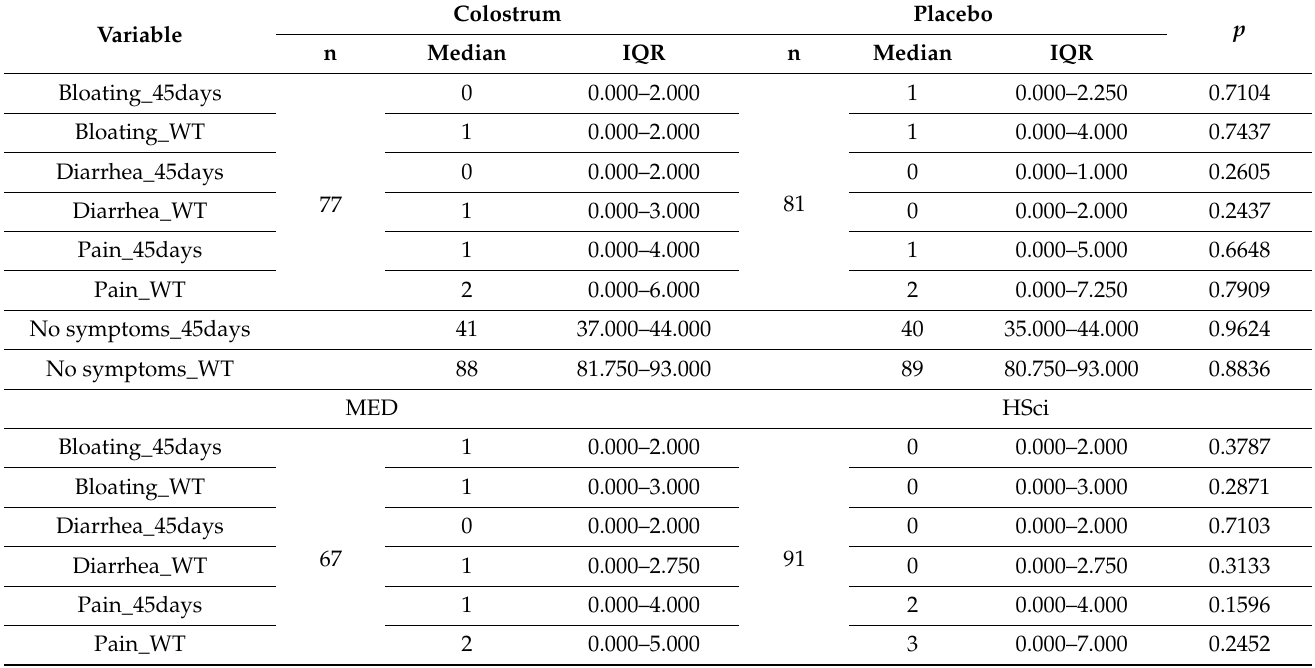
Figure 4. A bar plot on the efficacy of COL in shaping well-being score by the course of studies. Medians and IQRs are shown. Dots and squares depict individual cases. MED—medicine; HSci— health Science. Table 4. GI symptoms per person during first 45 days or whole trial (WT) period by faculty and